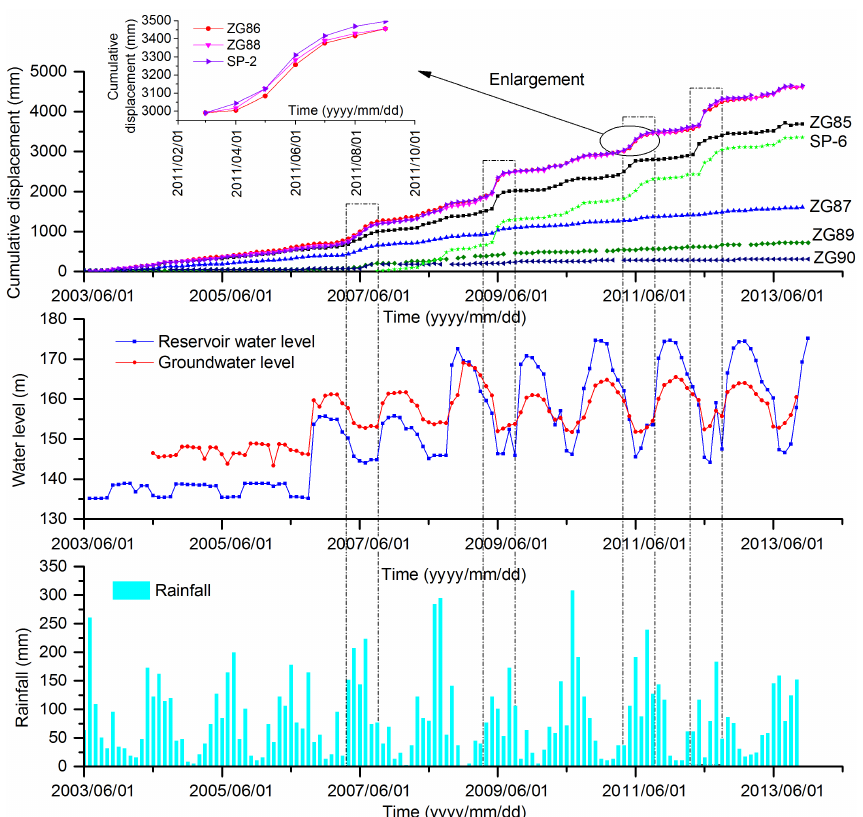
Figure 6. The relationships between rainfall, reservoir water level and displacement.